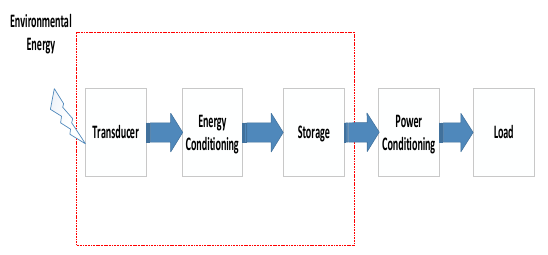
Figure 6: Block diagram of a self-powered system. The blocks inside the dashed red box form the energy harvester